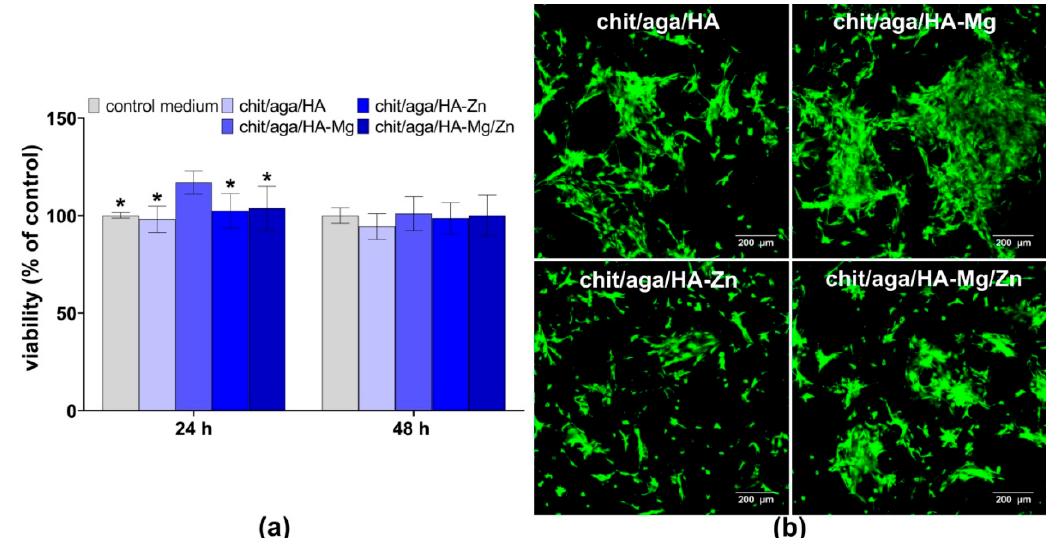
Figure 4. Cytotoxicity assessment of the scaffolds against mouse calvarial preosteoblast cell line (MC3T3-E1) cells: ( a ) MTT assay performed using scaffolds extracts (*statistically significant results as compared to chit/aga/HA-Mg extract, P < 0.05, one-way ANOVA followed by Tukey’s test); ( b ) confocal laser scanning microscope (CLSM) images presenting live-dead staining (viable cells, green fluorescence and dead cells, red fluorescence) of MC3T3-E1 cells cultured for 48 h on the surface of the scaffolds; magnified 100×, scale bar = 200 µm.